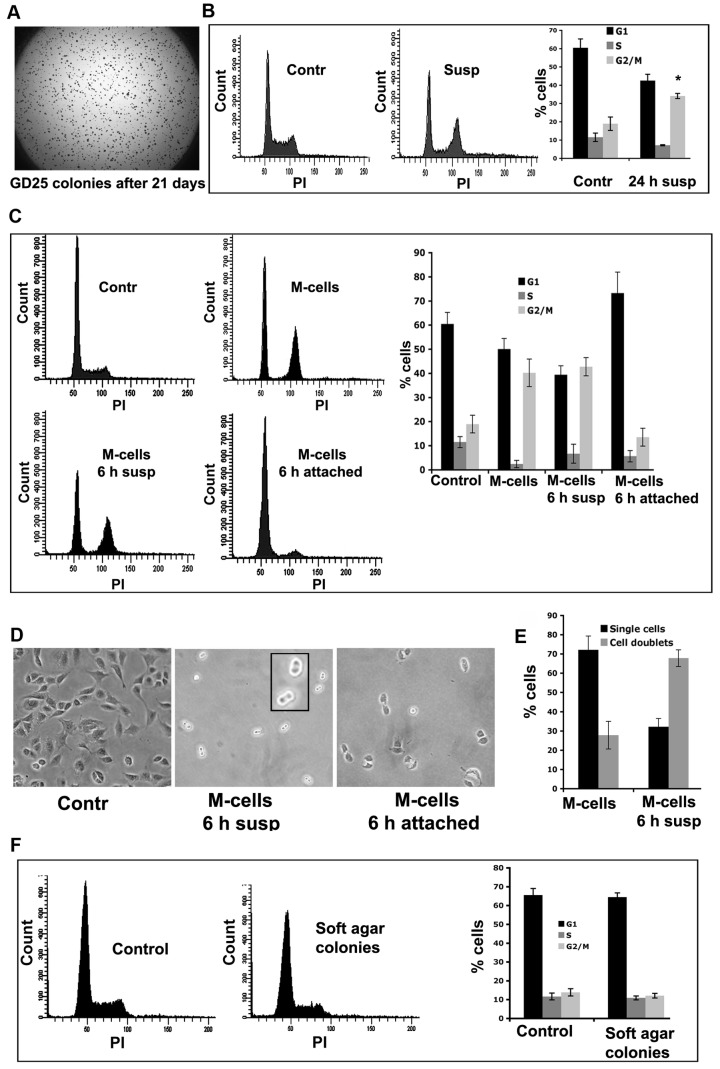
GD25 cells have functional cytokinesis-block and form colonies in soft agar.(A) GD25 cell colonies were stained with Methylene blue after growth in soft agar for 3 weeks. (B) GD25 cells were grown in suspension for 24 hours. Cells were fixed, stained with propidium iodine (PI) and analyzed by FACS. The increase in the G2/M cell population compared to the adherent control cells indicated that GD25 cells have functional cytokinesis block; (* represents P < 0.001 as evaluated by Student t test. The bars show the results from three independent experiments +/- SD. (C) GD25 M-cells were grown either in suspension or allowed to re-attach to tissue culture dishes. After 6 hours the cells were collected, fixed, stained with PI and analyzed by FACS. Cells in suspension retained the cytokinesis block, resulting in an increase in the G2/M population. However, attached cells finished cytokinesis, resulting in an increased G1 cell population. The bars show the results from three independent experiments +/- SD. (D) Phase contrast photographs of GD25-M cells taken before the FACS analysis described in (C). The same magnification (20 x) was used for the three pictures, and an enlargement of the two binucleated cells in the upper right corner of the middle frame (suspension culture) is shown in the inserted square. (E) Cell-doublets and single cells observed after 6 hours of suspension culture were counted and the percentages were plotted as a bar graph. The bars show the results from three independent experiments +/- SD; in each experiment at least 200 cells were counted. (F) GD25 cells in agar colonies completed cytokinesis. GD25 colonies isolated from soft agar at day 14 were trypsinized and subjected to FACS analysis. The histograms represent exponentially growing adherent cells (left histogram) and cells isolated from colonies grown in soft agar (right histogram). The distribution of cells in different cell cycle phases were quantified from three independent experiments and plotted as a bar graph +/- SD.